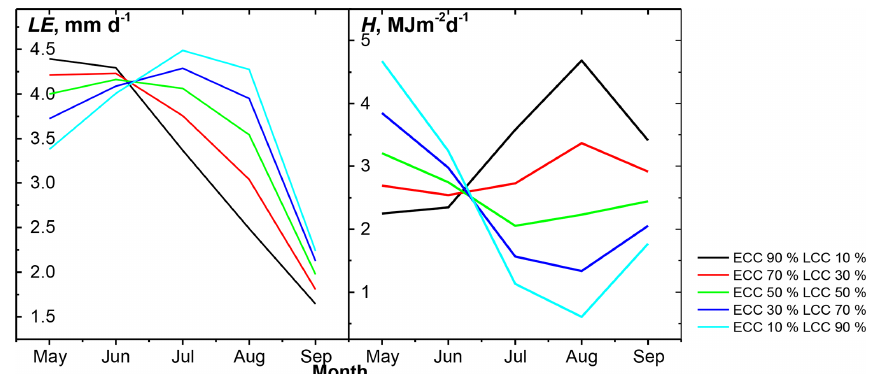
Figure 9. Simulation results of Noah-MP LSM for latent heat flux ( LE ) and sensible heat flux ( H ). Simulations were performed considering different shares of ECC and LCC.